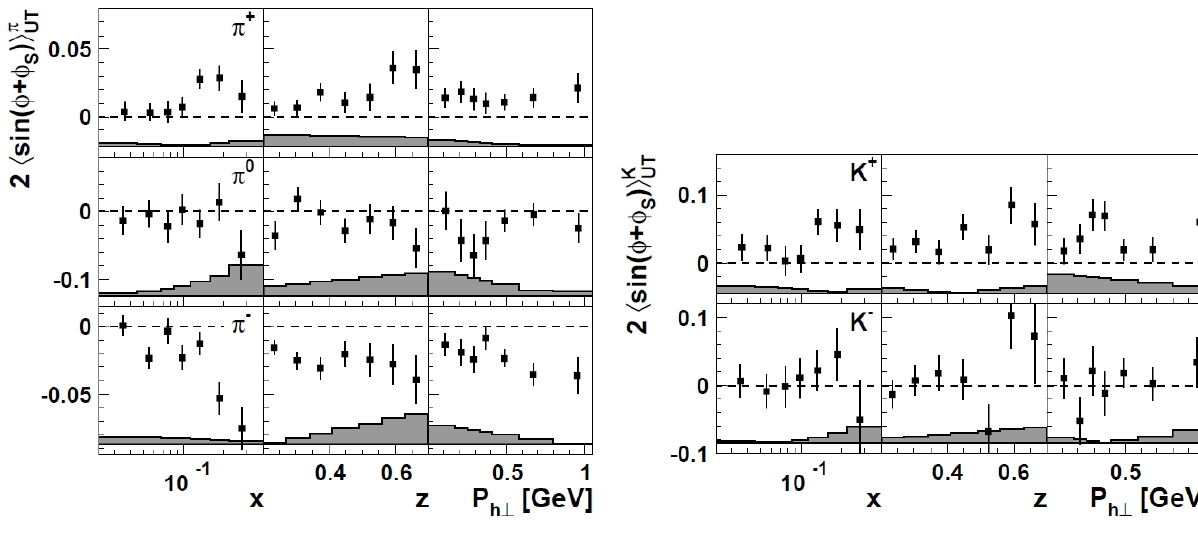
Figure 4. HERMES measurements of the Collins asymmetries on protons for π ± (left) and K ± (right).